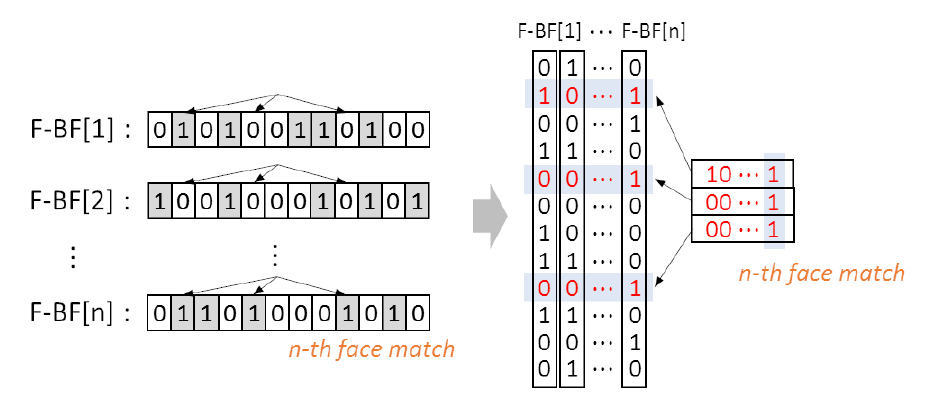
Figure 4. An example of F-BFs merging-to reduce the time for querying F-BF[i], where i = 1 · · · n . F-BFs are merged into one functional Bloom filter [19,26]. Algorithm 2: Procedure for querying